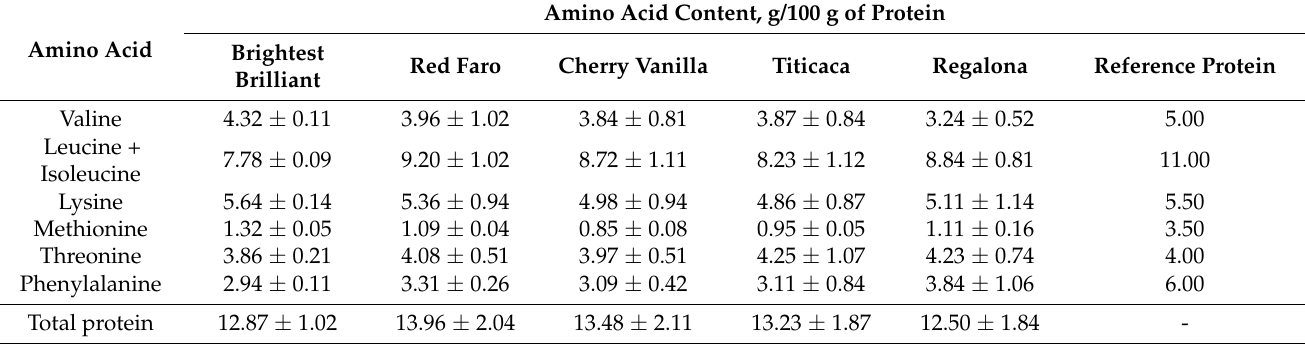
Table 6. Total protein content and amino acid composition of quinoa grains. Amino Acid Content, g/100 g of